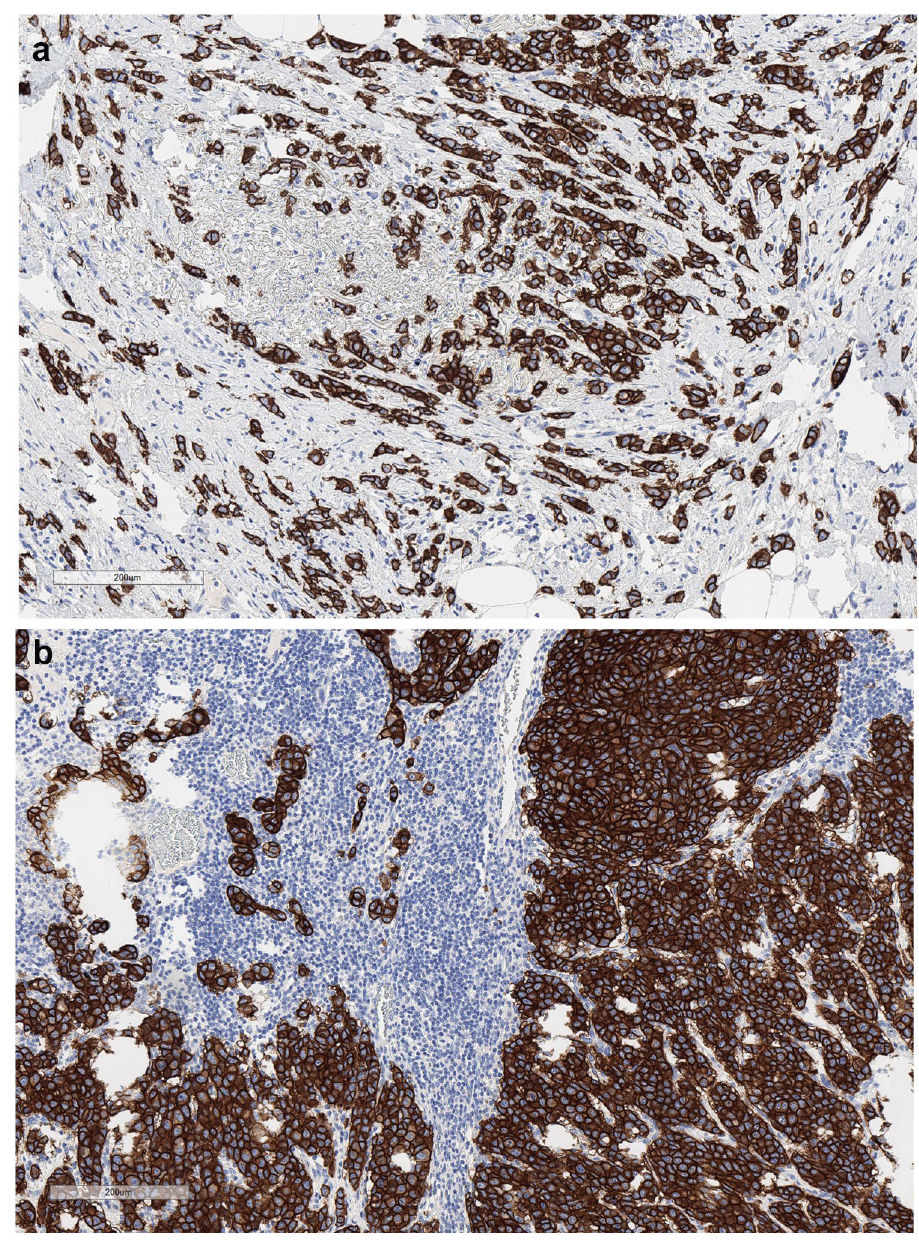
Figure 2. Histopathology example of a patient who maintained the HER2 status both in early and metastatic biopsy. At breast cancer diagnosis ( a ) the pathologists’ report called for “Membrane staining that is complete, intense and in ˃ 10% of tumor cells. IHC: 3 + .” At relapse ( b ), a cutaneous lesion in the ipsilateral breast was biopsied and the pathologists’ report exactly reproduced the prior